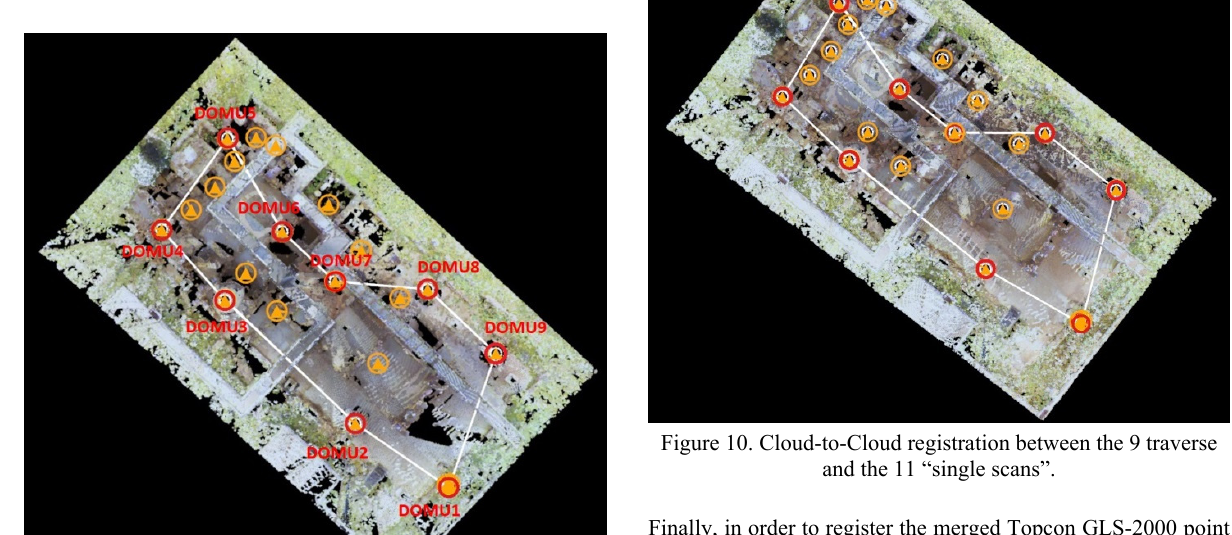
Figure 8. Panoramic image first (left) and after (right) Camera Raw adjustment